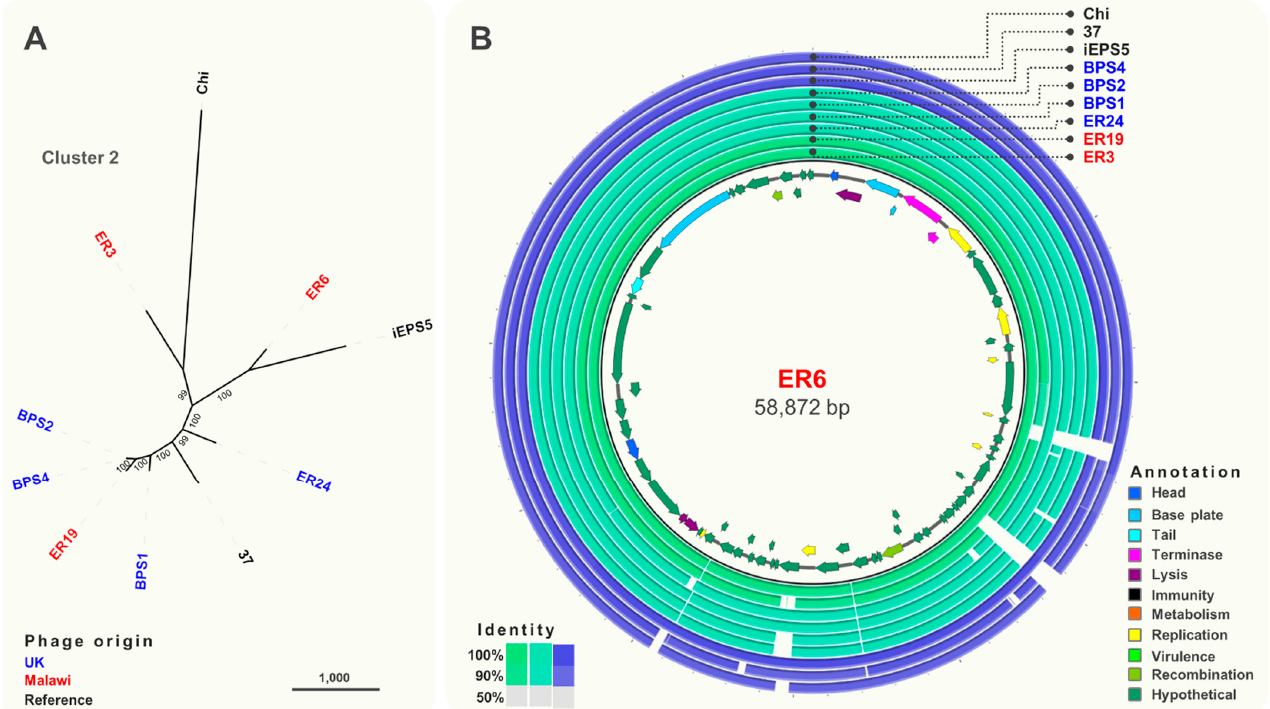
Figure 4. Comparative genomics of phages from Cluster 2. ( A ) Maximum-likelihood tree of phages in Cluster 2, unrooted and visualised in iTOL with numbers on branches indicating bootstraps. Scale bar represents number of single nucleotide polymorphisms. Phage names in blue were isolated from the UK and red from Malawi. Names in black font indicate reference phages. ( B ) Whole-genome comparison of phages in Cluster 2. The local similarity of each genome at the nucleotide level was calculated based on BLASTn high scoring pairs and plotted against a circular map of ER6 represented as the inner circle. Blue circles represent reference genomes. Genome annotation is shown as arrows in the inner circle, colour-coded based on gene categories. Full annotation can be found in Table S3.